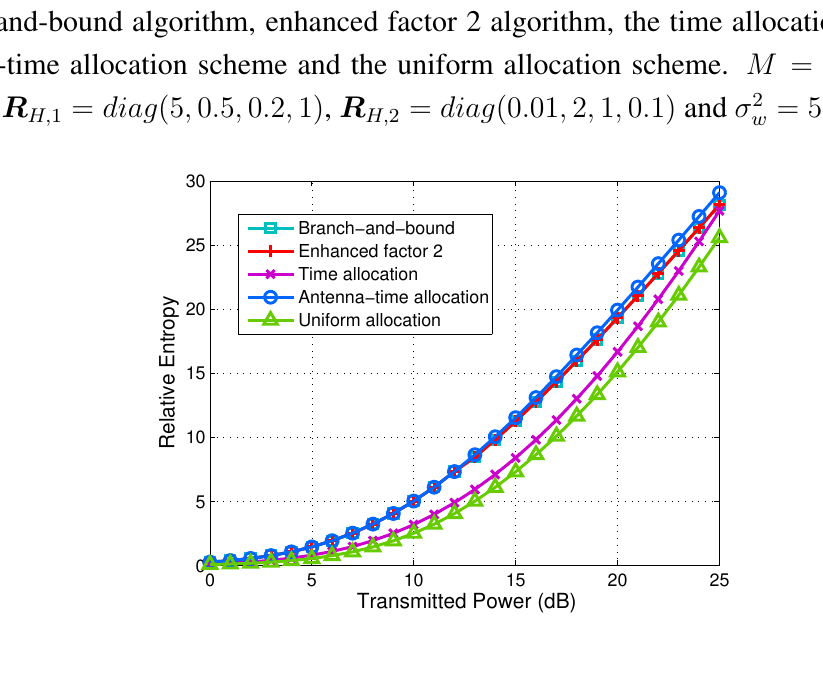
Figure 3. The antenna allocation results via branch-and-bound algorithm in the scenario of Figure 2: ( a ) the antenna allocation with the transmitted power ranging from 0 dB to 12 dB; ( b ) the antenna allocation with the transmitted power ranging from 13 dB to 25 dB. The antenna allocation result via the enhanced factor 2 algorithm is exactly the same as that via the branch-and-bound